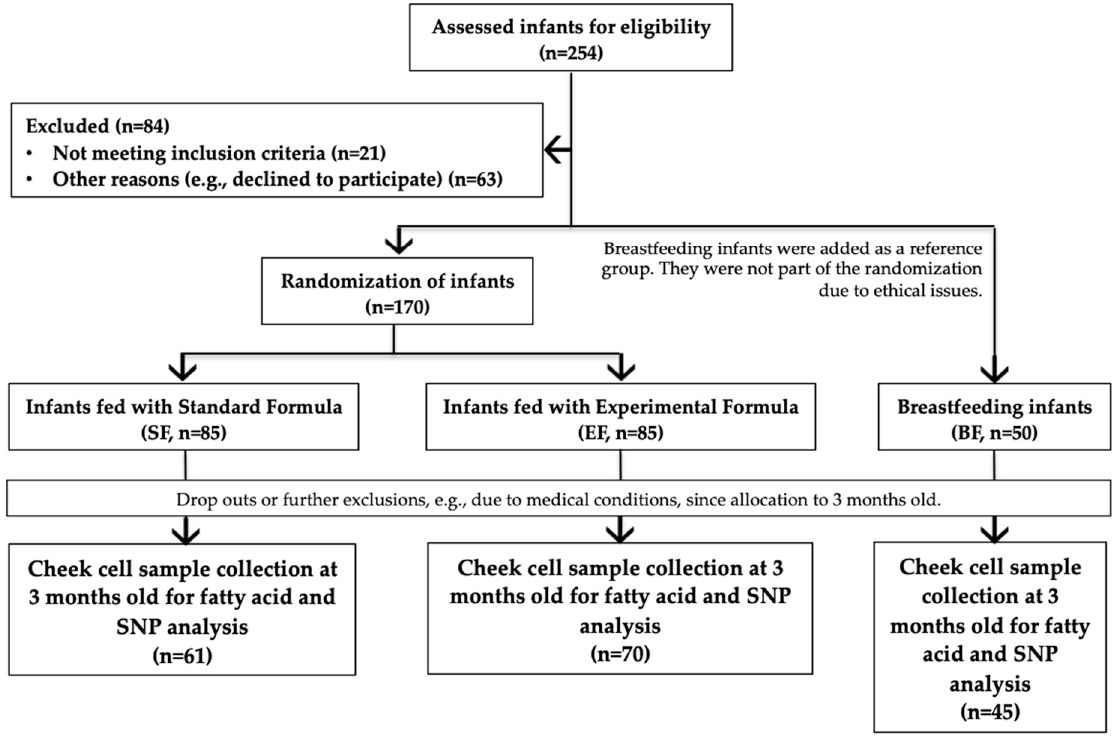
Figure 1. Participants in the COGNIS study and classification following type of feeding.